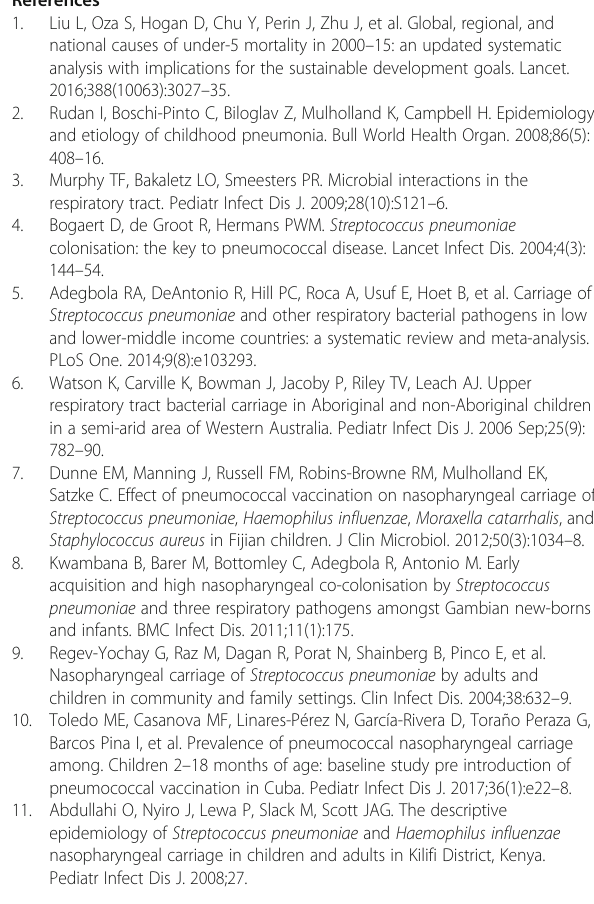
Additional file 1: Table S1. Univariable and multivariable analysis of risk factors for H. influenzae and S.aureus carriage. Table S2. Univariable and multivariable analysis of risk factors for carriage of two or more of the following species: S. pneumoniae , H. influenzae , M. catarrhalis , and S. aureus . Table S3. Linear regression analysis of factors associated with S. aureus density in children who are carriers ( n = 22). Table S4. Linear regression analysis of factors associated with the combined density of S. pneumoniae , H. influenzae , M. catarrhalis , and/or S. aureus in children colonized with of two or more bacterial species ( n = 125). (DOCX 50 kb) Abbreviations aOR: adjusted odds ratio; CI: Confidence intervals; GE: Genome equivalents; Hib: Haemophilus influenzae type B; HIV: Human immunodeficiency